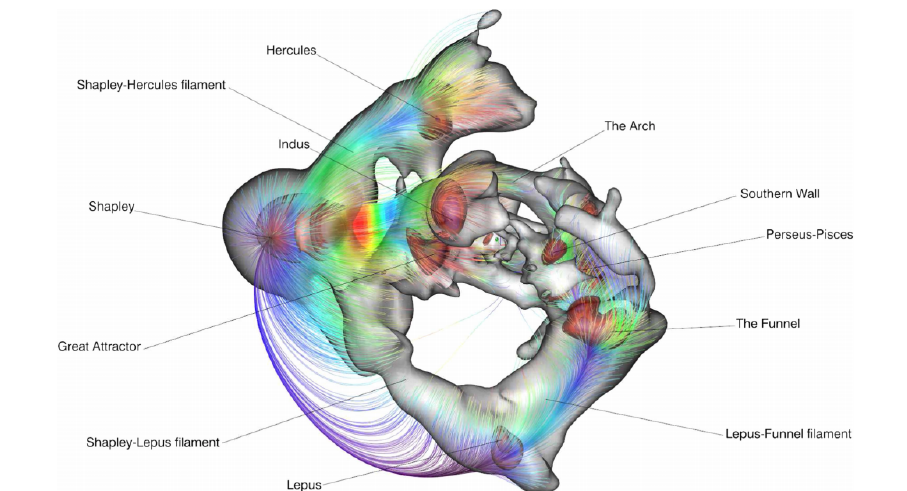
Figure 11. Sketchfab animation from the work in [139] where colors represent velocities and flows of matter in the universe. Knots are highlighted with redder tones with accelerated motion and bluer tones for less motion of the matter. The image shows a large scale flow pattern in the Shapley Concentration (a supercluster containing the highest number of galaxies in our close universe). Galaxies are attracted by gravitational attractors and and move away from empty regions; More on